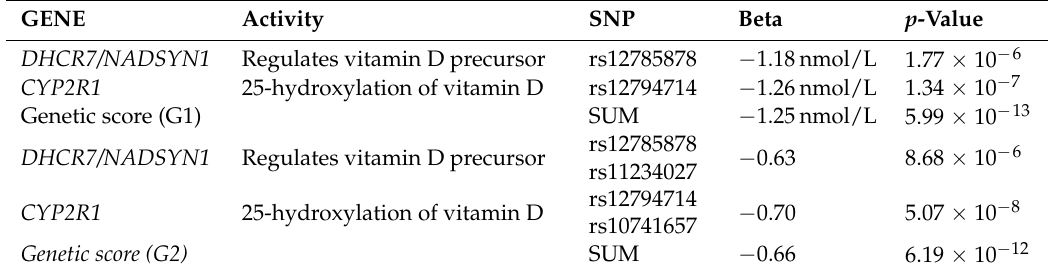
Table 2. SNP and genetic score association, adjusted only for study, with standardized 25-hydroxyvitamin D(25(OH)D). Beta represents the effect per allele count. SNP: single nucleotide polymorphism.